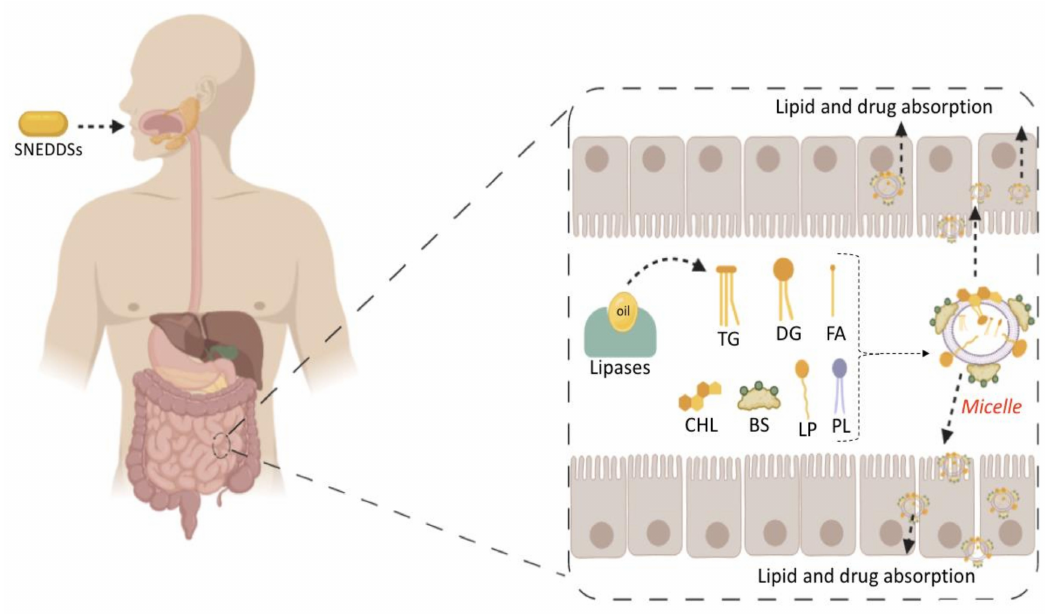
Figure 3. Lipid digestion and drug solubilization process in the small intestine. Abbreviation: triglycerides (TG), di-glycerides (DG), monoglycerides (MG), fatty acids (FA), cholesterol (CHL), bile salts (BS), lipoproteins (LP), phospholipids